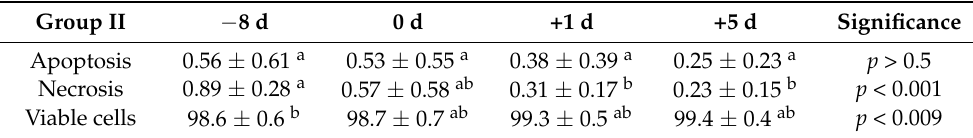
Table 6. Values representing the average and the standard deviation of the results of the apoptosis assay performed with blood samples collected from animals from group II (16 to 30), at moments − 8 d, 0 d, +1 d and +5 d. Statistical difference according to the Tukey–Kramer test—Beltsville, 2003.